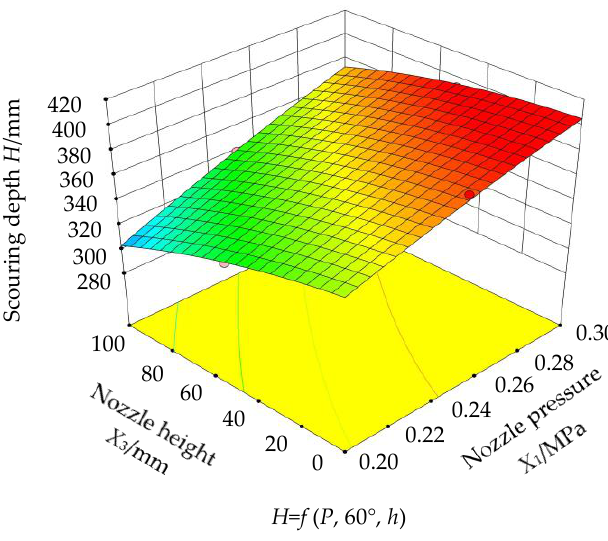
Figure 13. Response surface analysis.